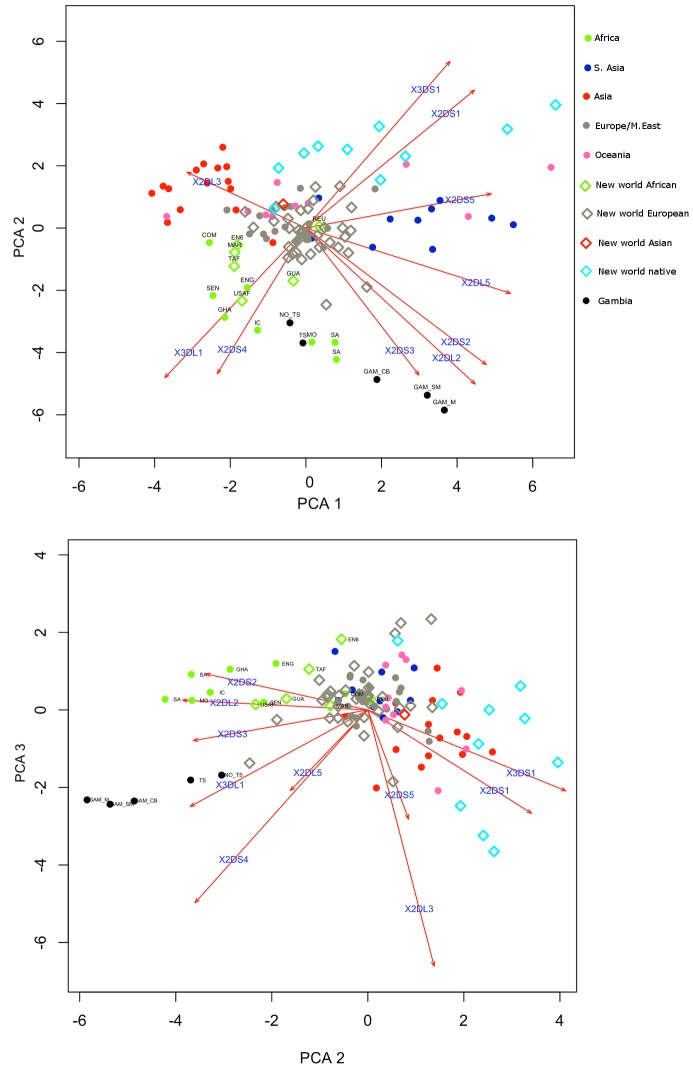
Principle Components Analysis of Gambian KIR frequencies and other world populations.African populations are characterised by high frequencies of the Cen-B (KIR2DS2∼KIR2DL2, KIR2DL2) and Tel-A (KIR3DS1∼KIR2DS4) haplotypes. Gambian samples, including the Po specimens and malaria cases cluster together and have some of the highest observed frequencies of Cen-B and Tel-A. The proportions of the total variance explained by the first three principal components were respectively 0.42, 0.28 and 0.11. Footnote to figure 3. NO_TS : Parents from Gambian trachoma families, unaffected, TS : Parents from Gambian trachoma families, affected, GAM_SM : Gambian severe malaria cases, GAM_M : Gambian uncomplicated Malaria cases, GCB : Gambian cord bloods, COM : Comoros, ENG : Equatorial New Guinea, GHA : Ghana, IC : Ivory Coast, MO : Morocco, SEN : Senegal, SA : South Africa, EN6 : England – West Midlands Afro-Caribbean, GUA : Guadaloupe, MAR : Martinique, REU : Reunion, TAF (Trinidad Africans), USAF : USA Californian African Americans.